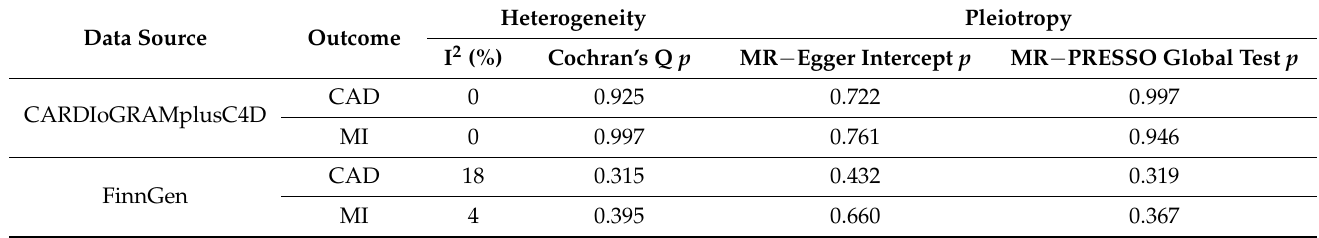
Table 3. Evaluation of heterogeneity and directional pleiotropy using different